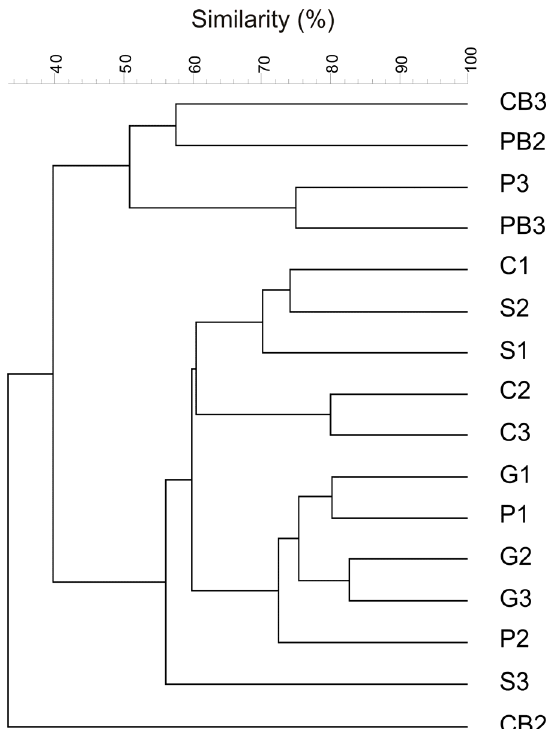
Fig 3. Dendrogram of soil samples based on cluster analy- sis of the DGGE profiles of microbial communities. Sam- ple codes are given in Table 2. Numbers after sample name indicate the year soil samples were taken (1 – 2001, 2 – 2002, 3 –